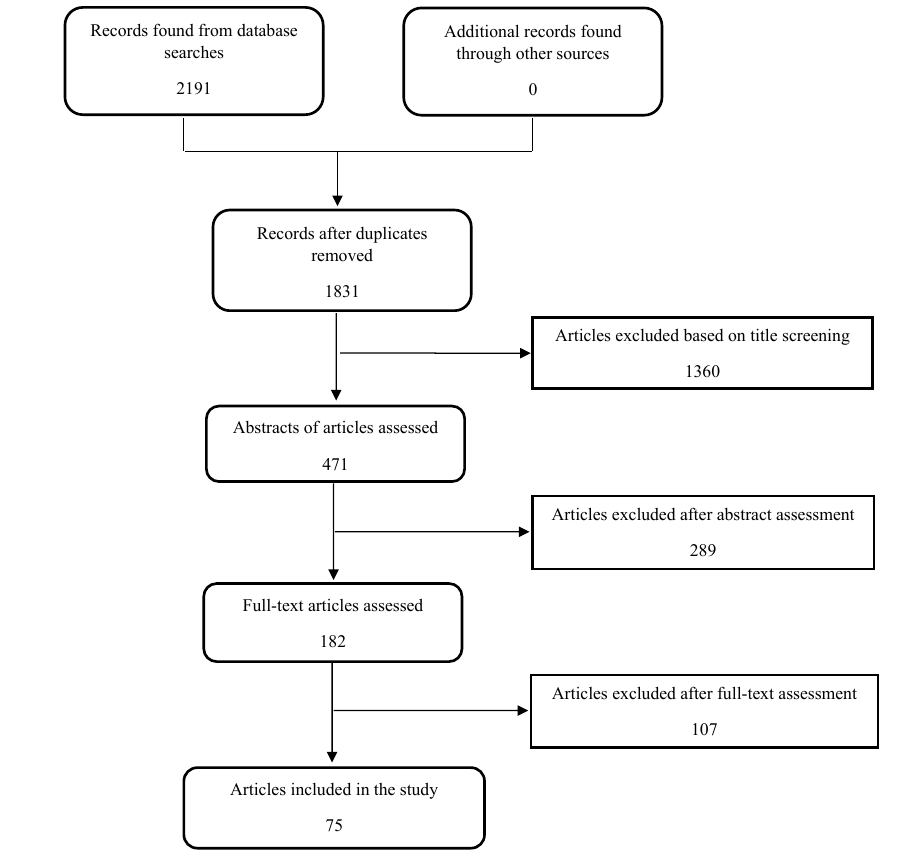
Figure 1. Flow Chart of the Article Selection